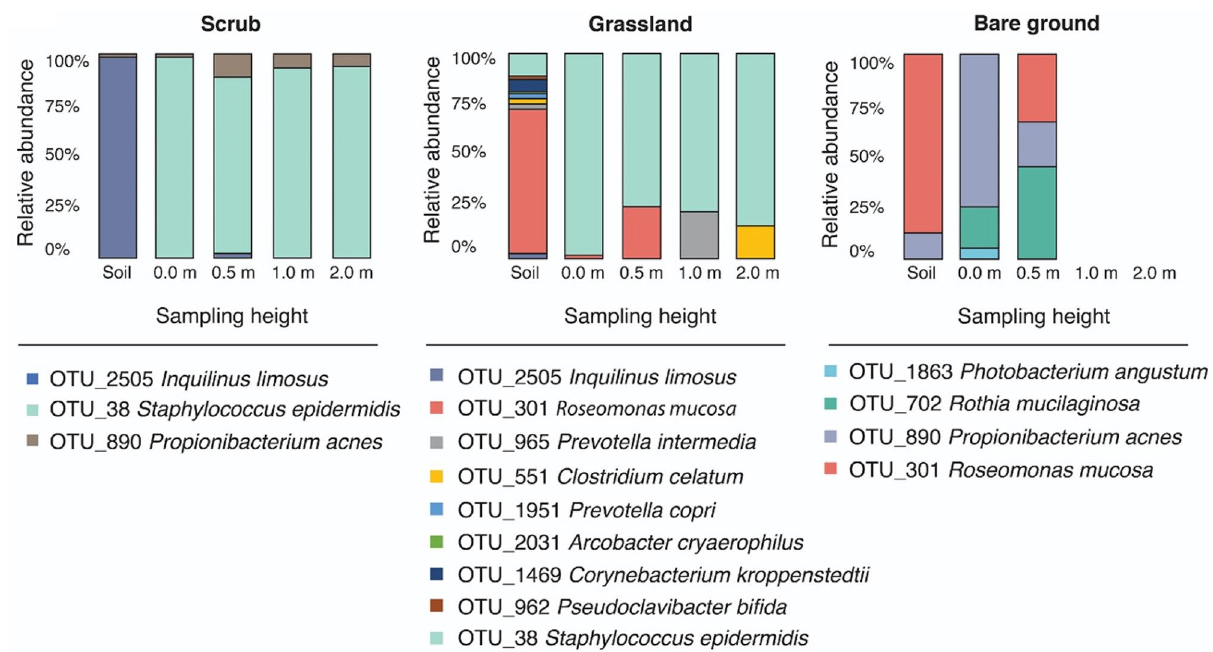
Figure 7. Potentially pathogenic and differentially abundant species for each habitat and their relative abundance for each sampling height. More details on the diseases these pathogens may cause are in Supplementary Materials, Appendix D, Fig.